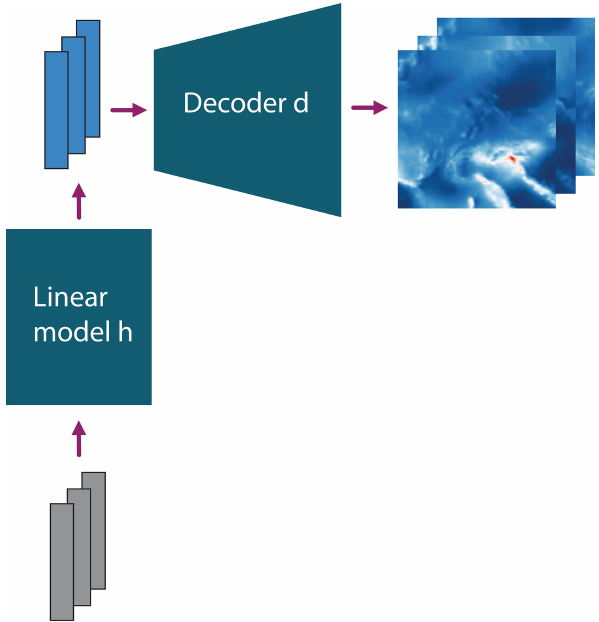
Figure 2. Illustration of the Latent Linear Adjustment Autoencoder after training: the input features X (illustrated in grey) are fed to the linear model h which yields a prediction for the latent space variables L (illustrated in light blue). These are in turn fed to the decoder which computes a prediction of the spatial field based on X only, ˆ Y X . Training the models e , d , and h is performed iteratively in an alternating